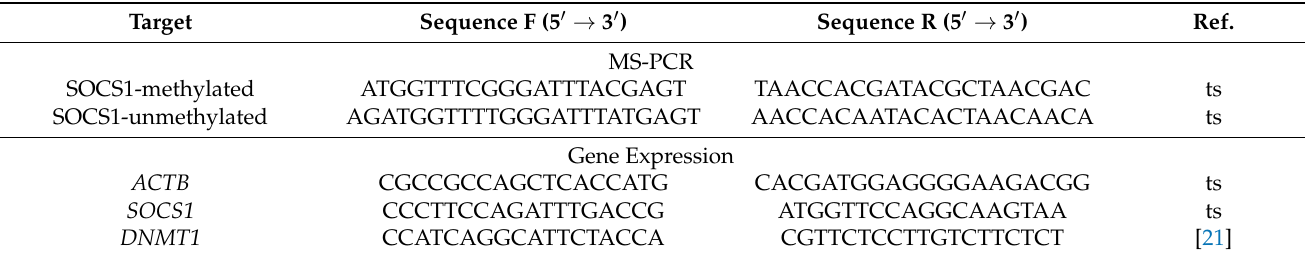
Table 1. List of